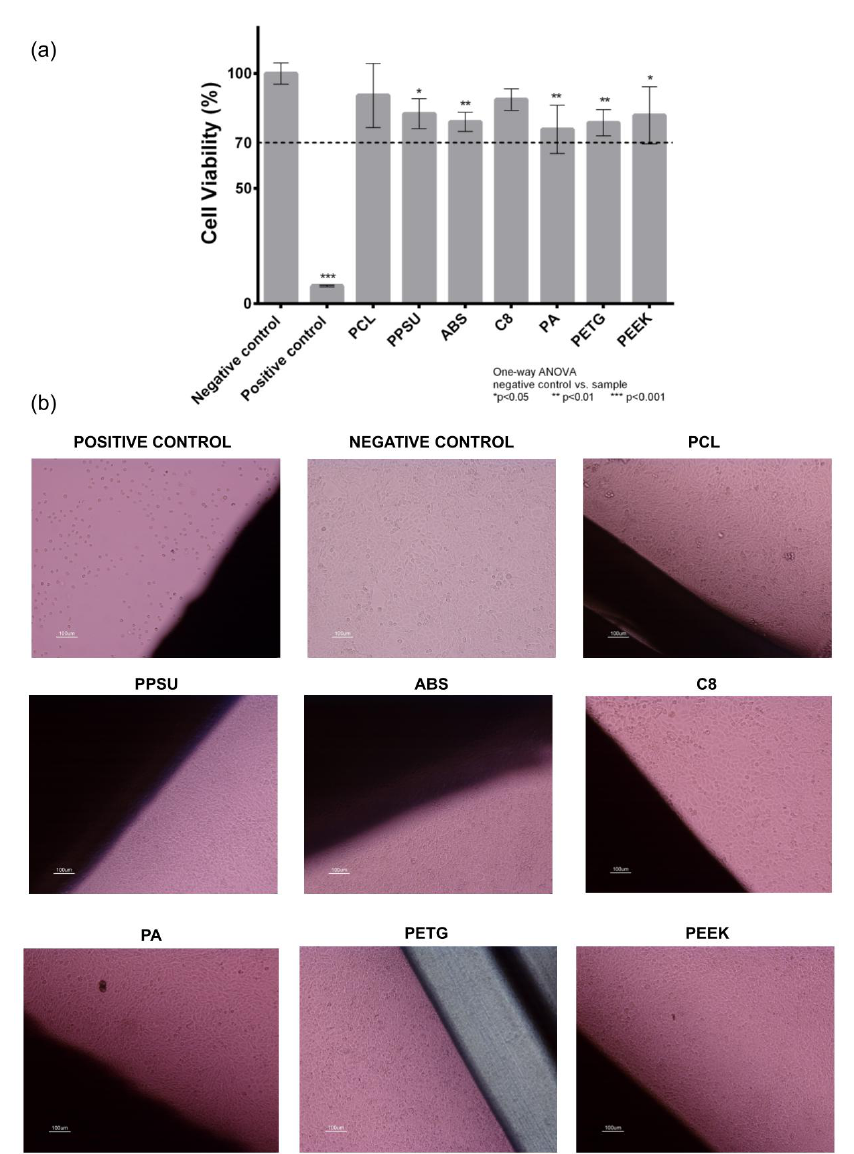
Figure 3. Cytotoxicity assay with L929 mouse fibroblast according to ISO 10993-5 standards: ( a ) indirect contact (MTT protocol); ( b ) direct contact (digital images of the material samples and the negative and positive controls, fresh culture medium and Latex, respectively). A one-way ANOVA with no corrections for multiple comparisons (Fisher’s test) statistical analysis was performed using GraphPad